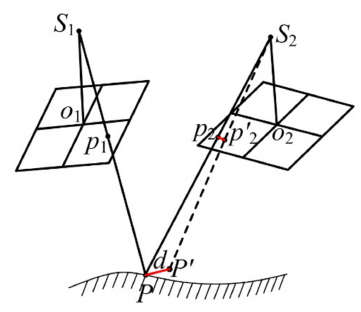
Figure 11. The illustration of using forward intersection residuals to eliminate wrongly matched points.